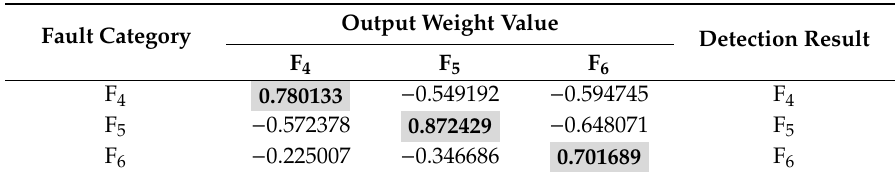
Table 4. Fault detection results under the failure of di ff erent switches in b -phase (inverter frequency = 60 Hz).